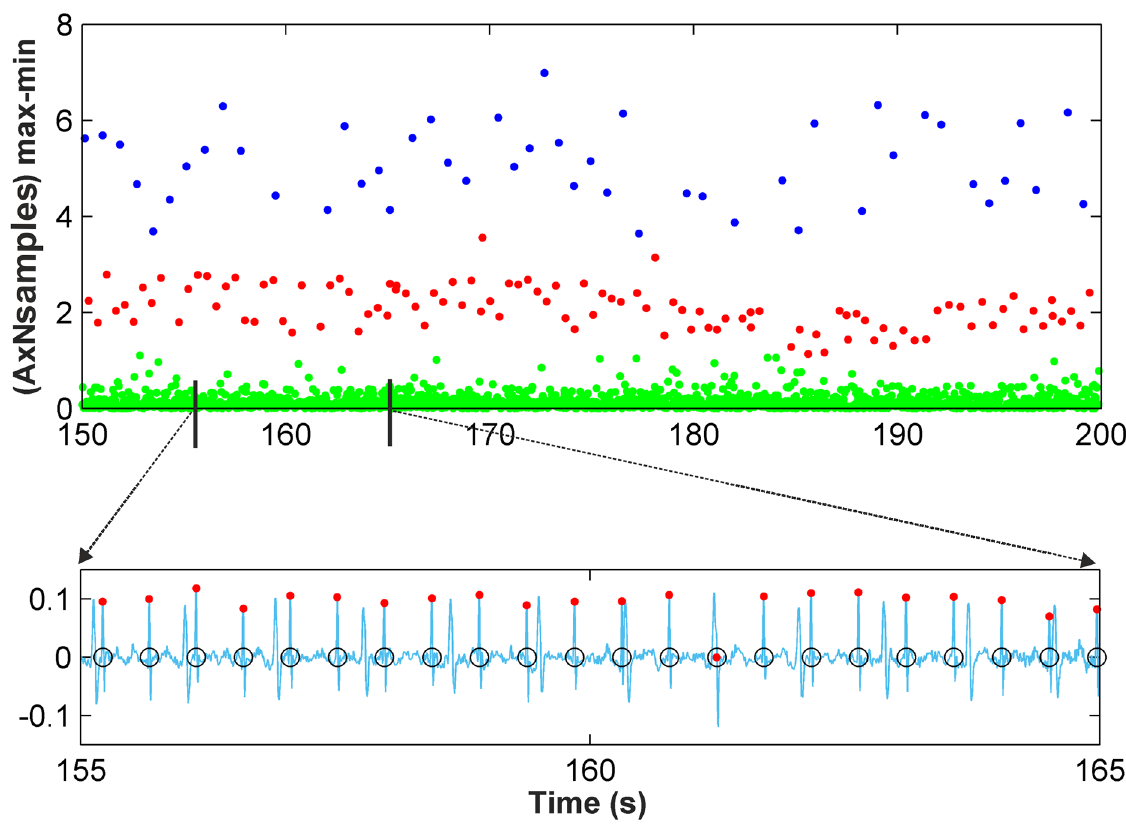
Fig 7. Clustering classification for r08 Ab-1